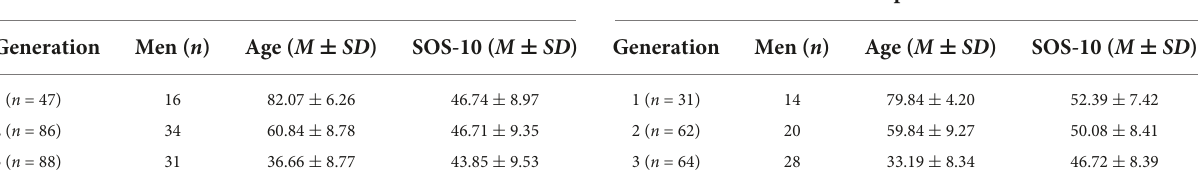
TABLE 1 Descriptive statistics of the focal and comparison groups. Focal